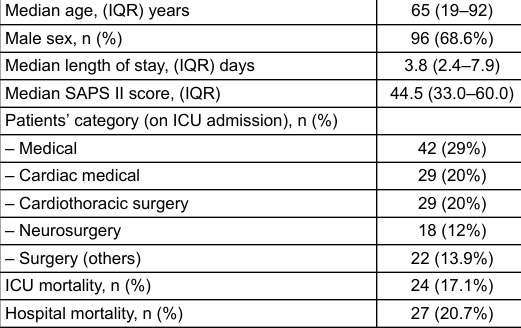
Table 1: Patients’ characteristics (n =